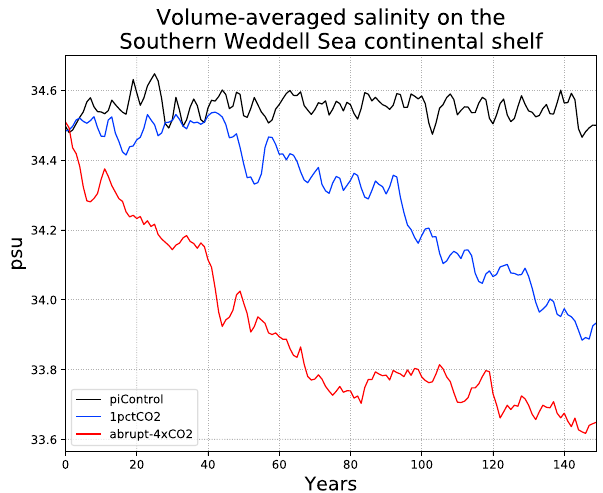
Fig. 2 Timeseries of salinity over the Southern Weddell Sea continental shelf. Results are shown annually-averaged for each simulation, and the region is de fi ned in Supplementary Fig. 5.